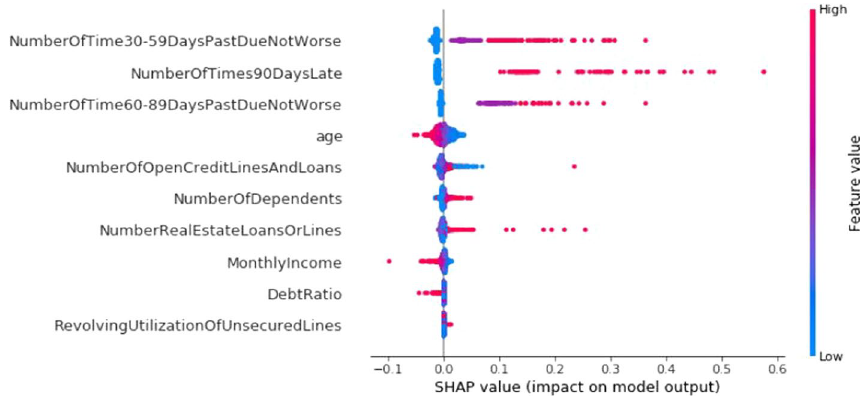
Fig. 8 SHAP interpretation of Deep Learning in the empirical